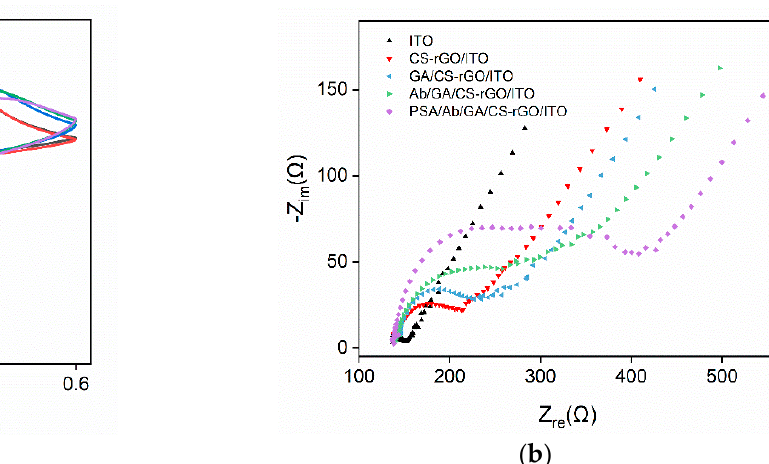
Figure 4. Cyclic voltammetry ( a ) with EIS curves ( b ) from different electrodes. The electrolyte solution was Fe(CN) 63 − /4 − (2.5 mM) containing 0.1 M KCl.